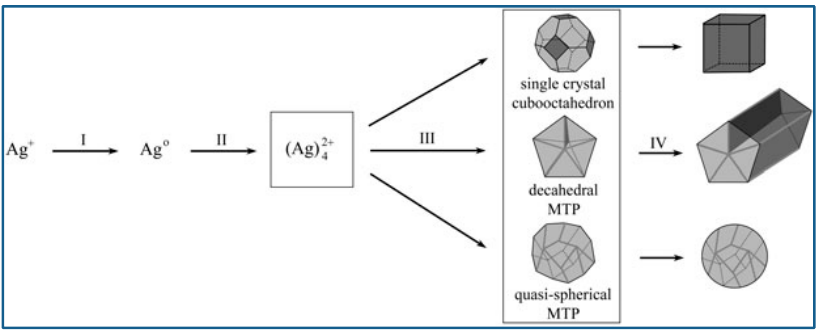
Figure 4. Schematic illustration of reduction of Ag + ions by ethylene glycol. Reproduced with permission [29]. Copyright 2005, Wiley-VCH.